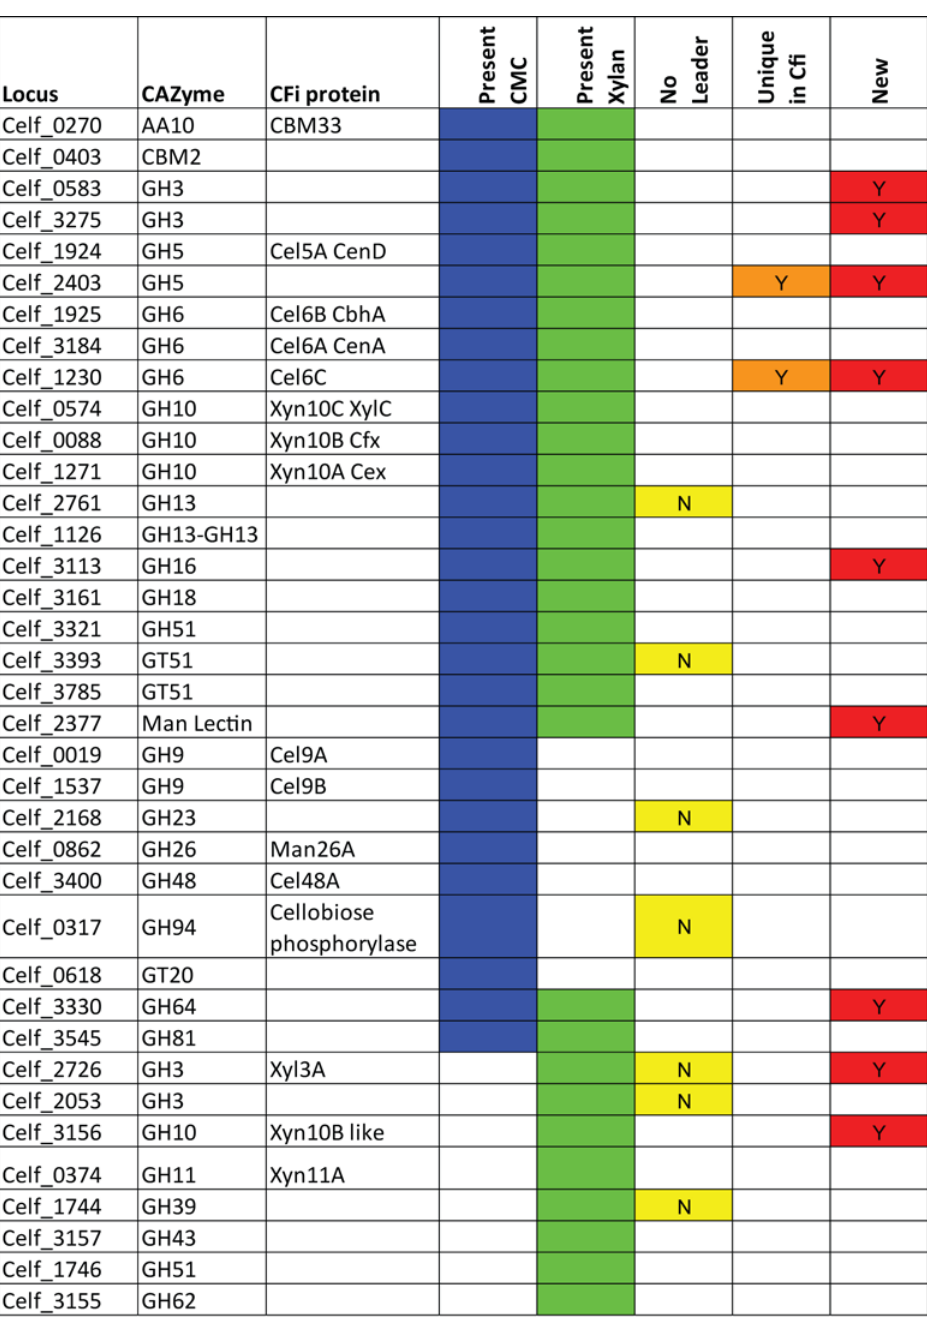
PLOS ONE | DOI:10.1371/journal.pone.0151186 March 7,